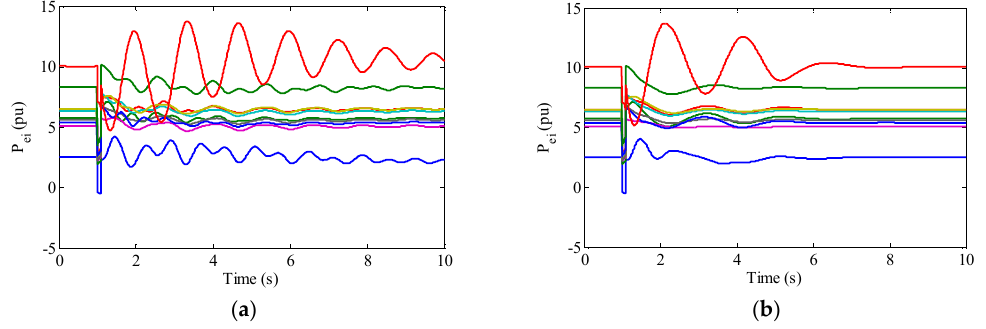
Figure 9. Electrical power response against a short circuit under operating condition 1. ( a ) Conventional PID governor controller; ( b ) Nonlinear synergetic governor controller.